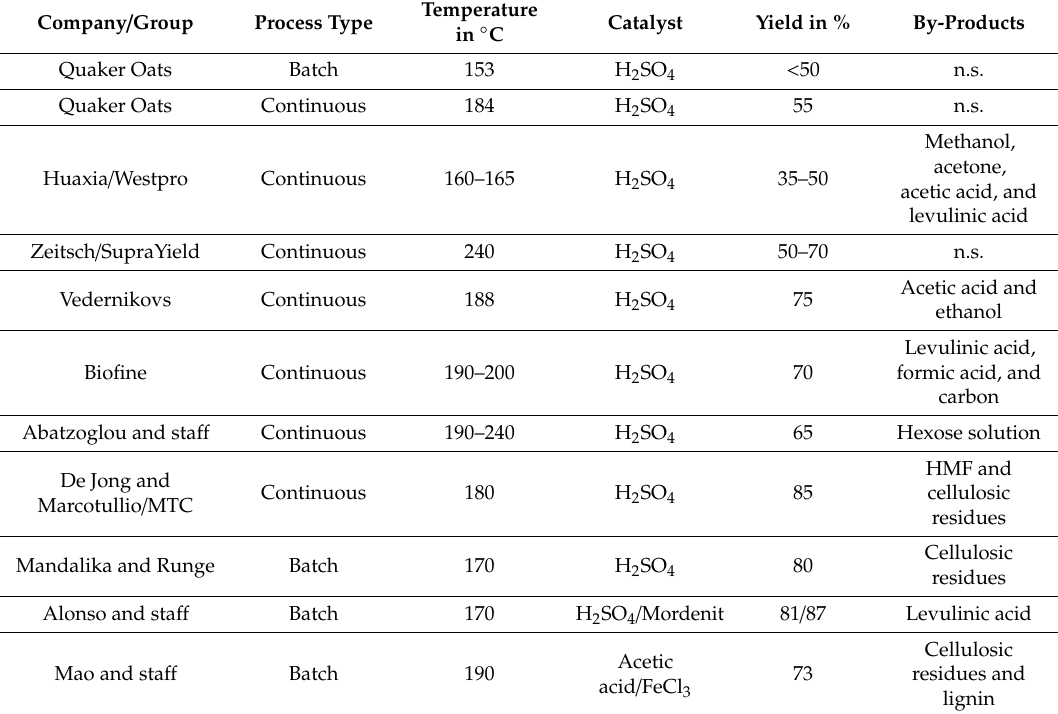
Table 3. Identified various processes for the production of furfural (derived from the literature [9]). Company /